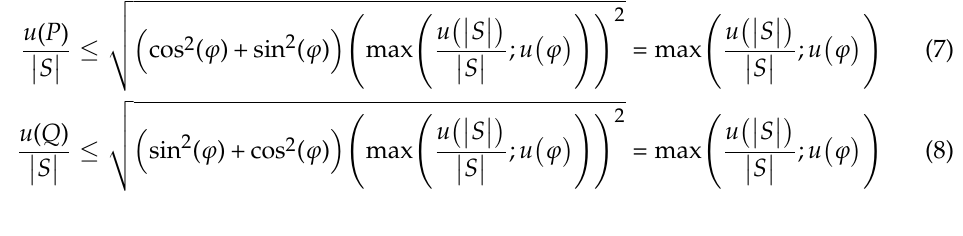
Table 6. Uncertainty of the active and reactive